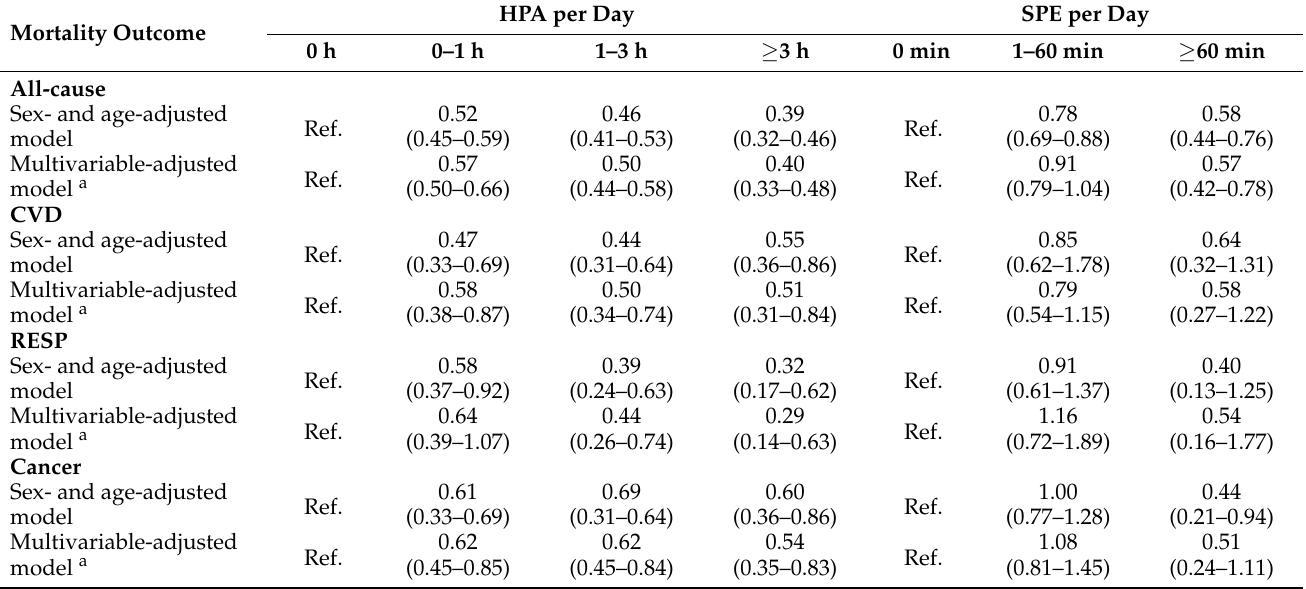
Table 3. Effects of HPA and SPE on all-cause, CVD, RESP, and cancer mortality.